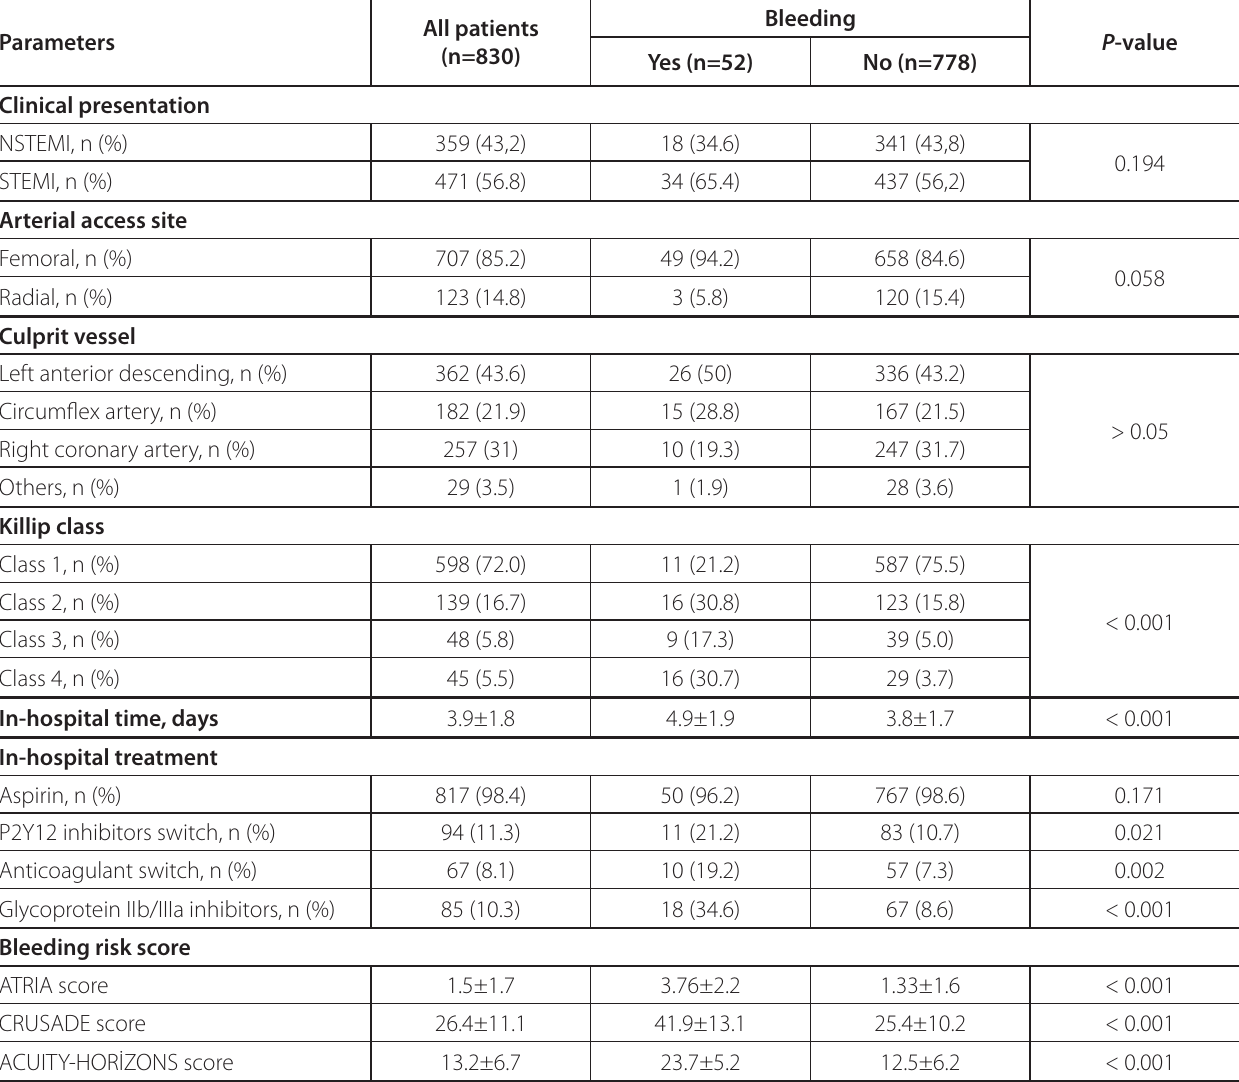
Table 2 . Baseline clinical characteristics, in-hospital treatment, and bleeding scores of the study sample.